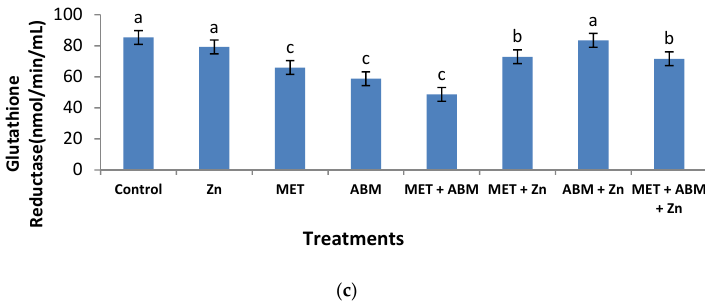
Figure 1. Effect of methomyl (MET), abamectin (ABM), and their mixture (MET+ABM), with and without zinc (Zn), on levels of glutathione ‐ S ‐ transferase(GST), glutathione peroxidase (GPx), and glutathione reductase (GR)in the plasma of male rats. Statistics: bars represent the group means ± SD; n = 8. Values of similar superscript letters are not statistically different. Values of superscript “b”are significantly different than those of superscript “a” at p ≤ 0.05; Values of superscript “c” are high significantly different than those of superscript “a” at p ≤ 0.01. ( a ) = glutathione ‐ S ‐ transferase (GST); ( b ) = glutathione peroxidase (GPx); ( c ) = glutathione reductase (GR). The activity of glutathione peroxidase (GPx) (Figure 1b) in the control treatment (0.87 μ mol/min/mL) was significantly ( p ≤ 0.01) higher than the values recorded for MET, ABM, and MET+ABM (0.73, 0.76, and 0.69 μ mol/min/mL, respectively). Co ‐ administration of Zn with the individual pesticides or their mixture limited decline of GPx activity to some extent ( p ≤ 0.05).